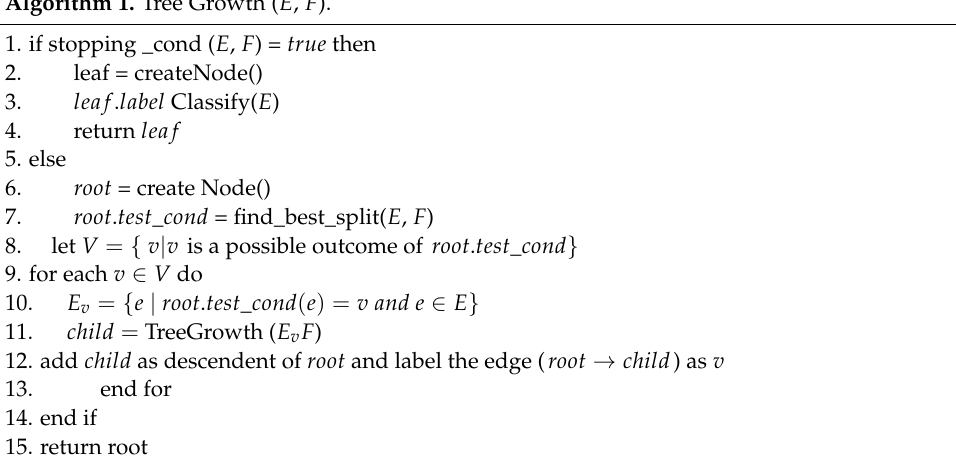
Algorithm 1. Tree Growth ( E , F ).